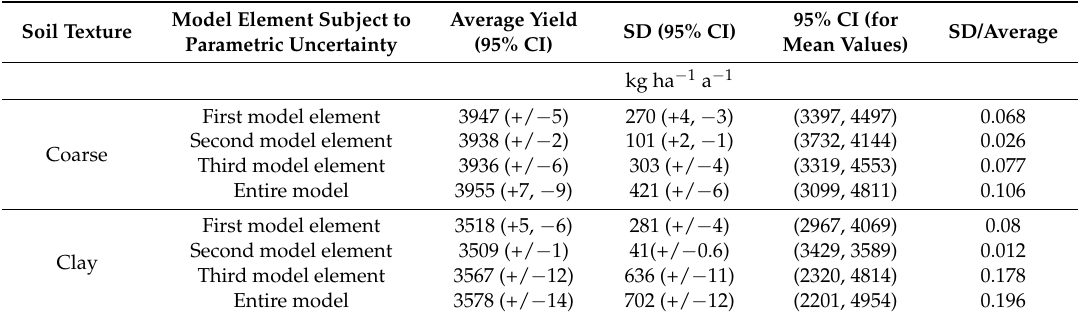
Figure 5. Steady-state yields for ( a ) coarse-textured soils and ( c ) clay soils determined by the different model candidates, and the associated economic losses resulting from incorrect model specification measured in differences in net present value (NPV) for ( b ) coarse and ( d ) clay soils. The dashed line indicates the level associated with the best model candidate. Table 7. Summary of the Monte Carlo analysis results used for examining the effect of the parametric uncertainty on model output (the barley yield), associated with individual model elements and the entire model for coarse and clay soils †